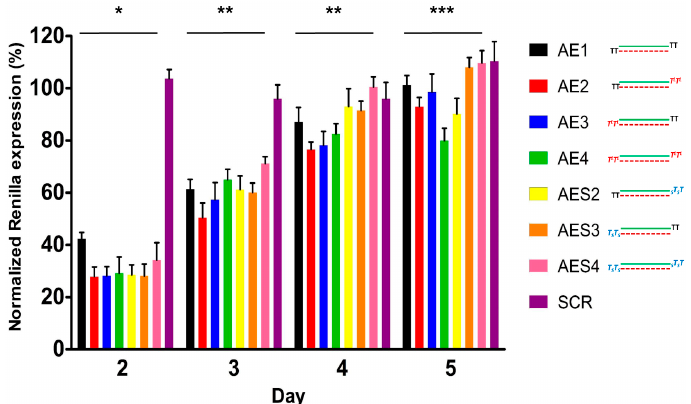
Figure 3. Time course in HeLa H/P. n = 3 ± SD. * = p < 0.05; ** = p < 0.01; *** = p <